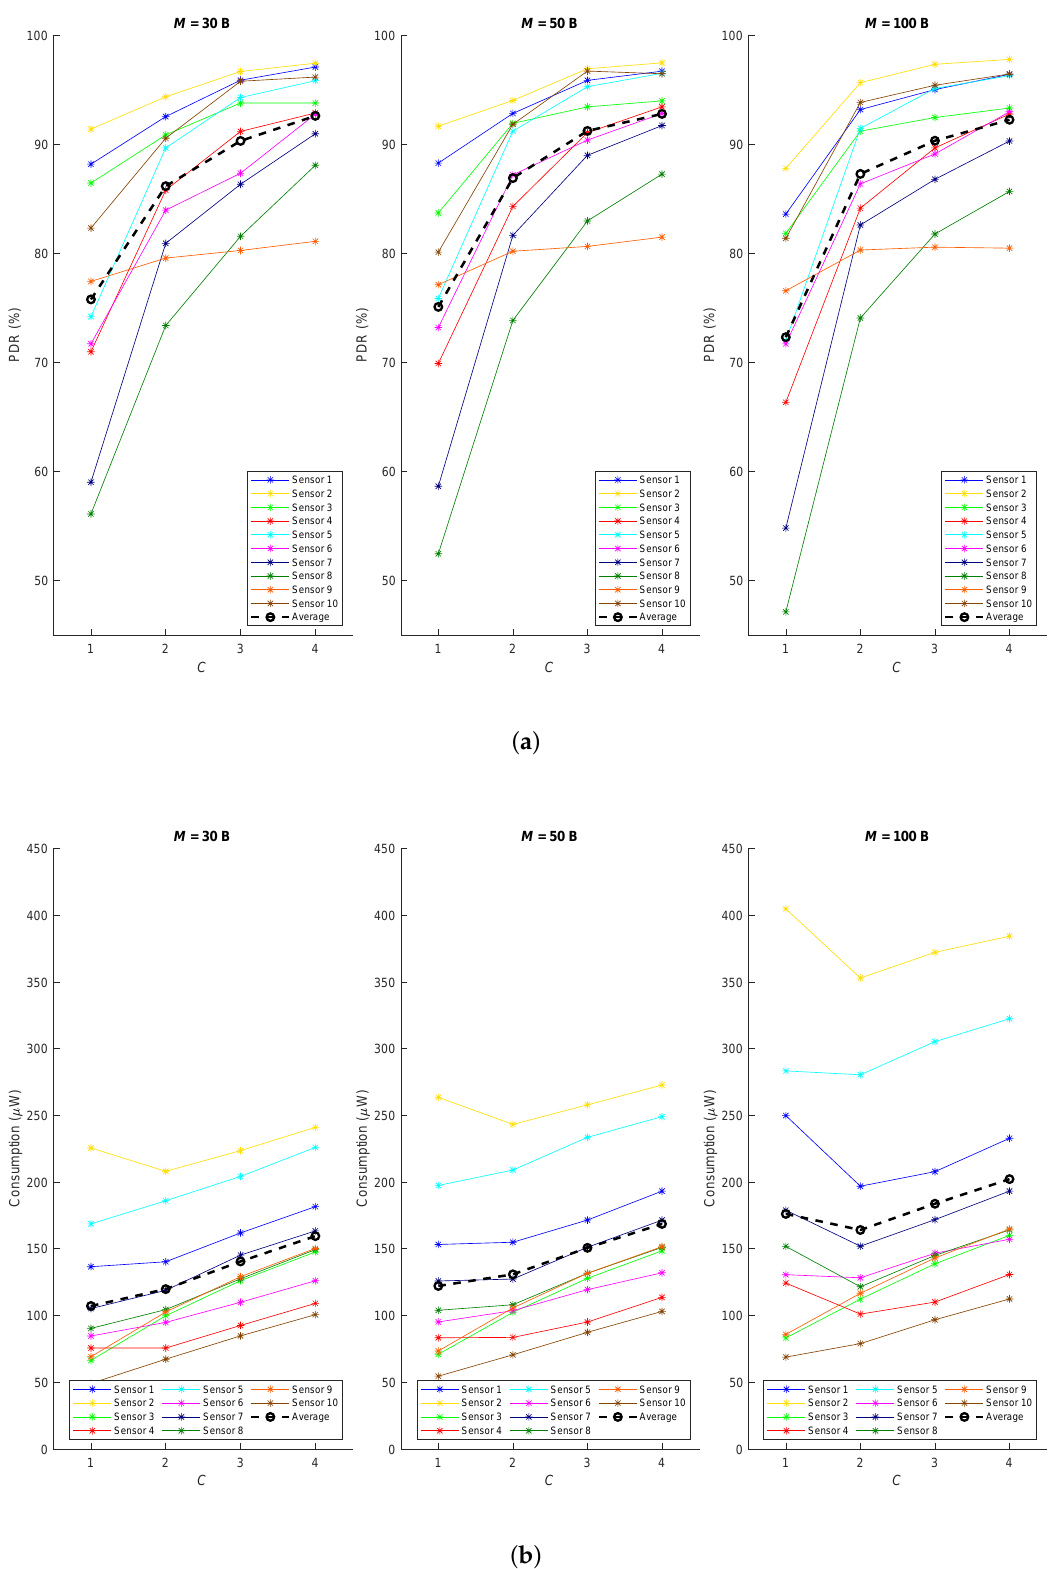
Figure 9. Results for the Testbed1 ( a ) PDR and ( b ) power